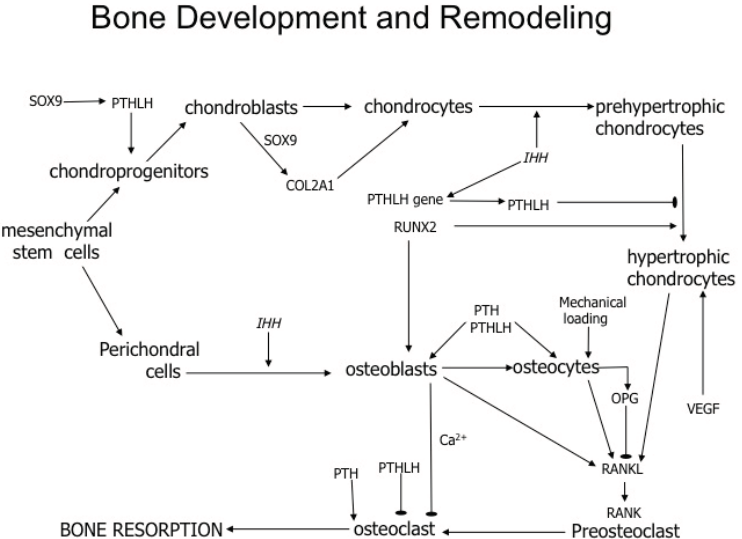
Figure 1. Summary of cellular events and transcription factors that regulate bone development and remodeling. Mesenchymal stem cells give rise to pathways for chondrogenesis